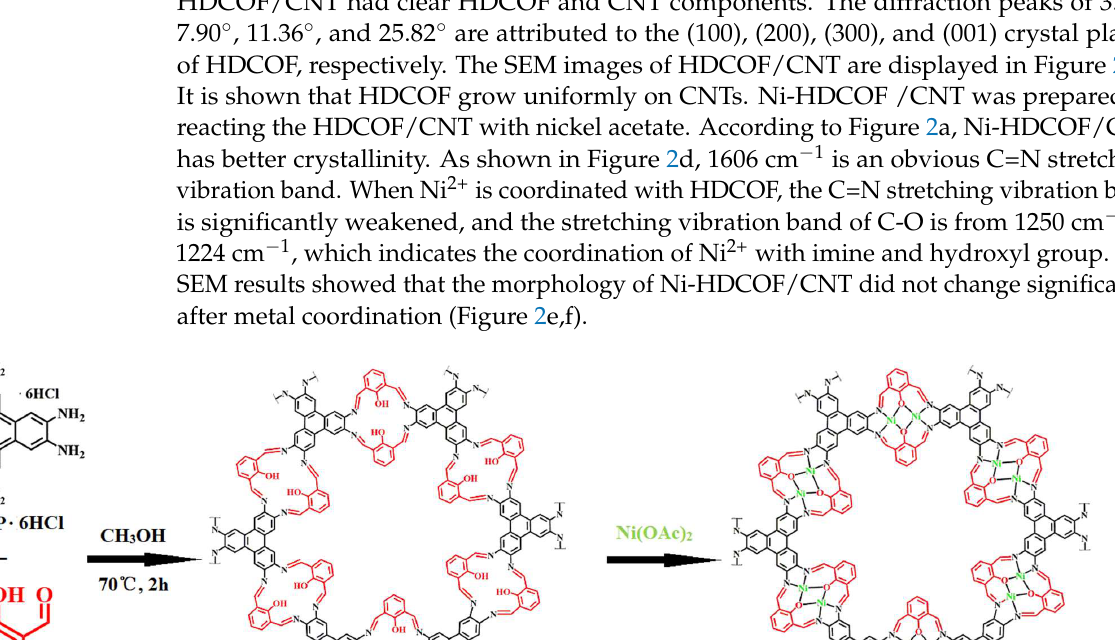
Figure 2. ( a ) XRD pattern of HDCOF and Ni-HDCOF/CNT. ( b , c ) SEM images of HDCOF/CNT. ( d ) IR spectrum of Ni-HDCOF/CNT. ( e , f ) SEM images of Ni-HDCOF/CNT. ( g ) XRD pattern of Ni-NiS/CNF. ( h , i ) SEM images of Ni-NiS/CNF. Then, the prepared Ni-HDCOF/CNT composites were carbonized at 700 °C under sulfur atmosphere to obtain Ni-NiS/NCF composites. As shown in Figure 2g, the diffraction peak at 26.5° is attributed to the (002) crystal plane of graphitic carbon. The three diffraction peaks at 44.50°, 51.84°, and 76.37° can be attributed to the (111), (200), and (220) crystal planes of Ni, while the three diffraction peaks at 31.36°, 50.07°, and 55.29° are attributed to the (300), (410), and (321) crystal planes of NiS. XRD results showed that metal and metal sulfide complexes were formed after vulcanization in Ni-NiS/NCF. It can be observed from SEM images that Ni-NiS-doped porous carbon